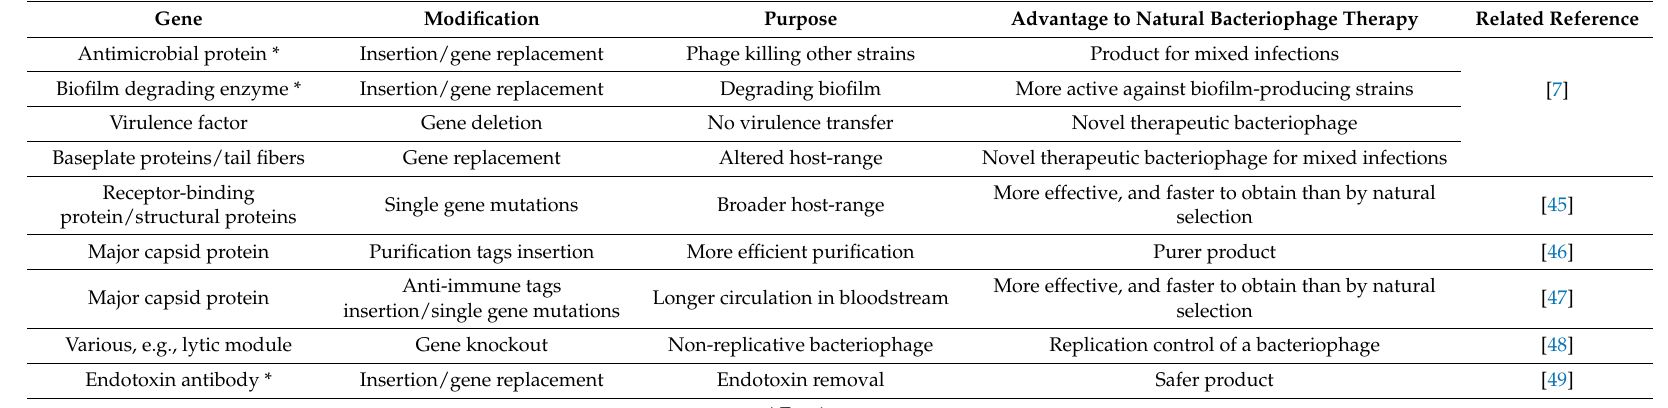
Table 3. Targets for genetic engineering for bacteriophage therapy applications.